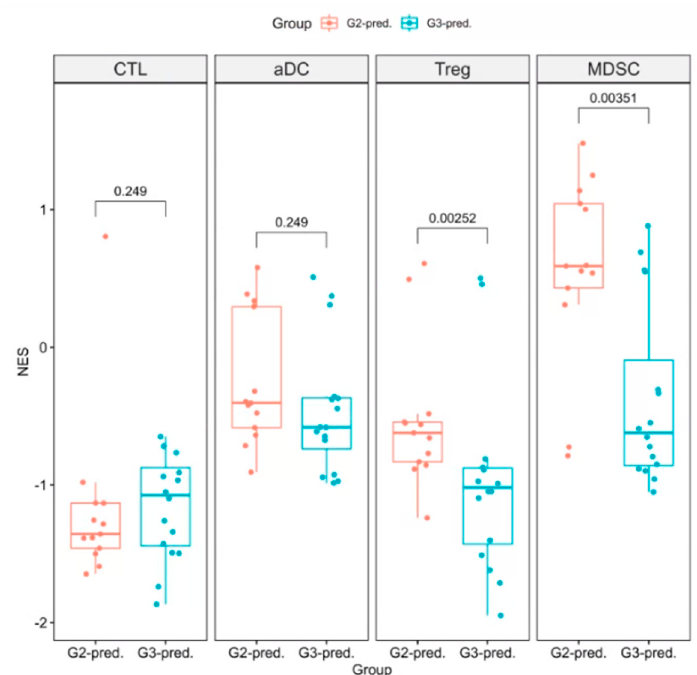
Figure 4. Effectiveness of models for T1C with G2- and G3-prediction groups. G2- and G3-prediction groups were determined using independent testing data ( n = 84) fed to the T1C radiomics models. The log-rank test for the survival curves between the two groups indicated statistical significance.